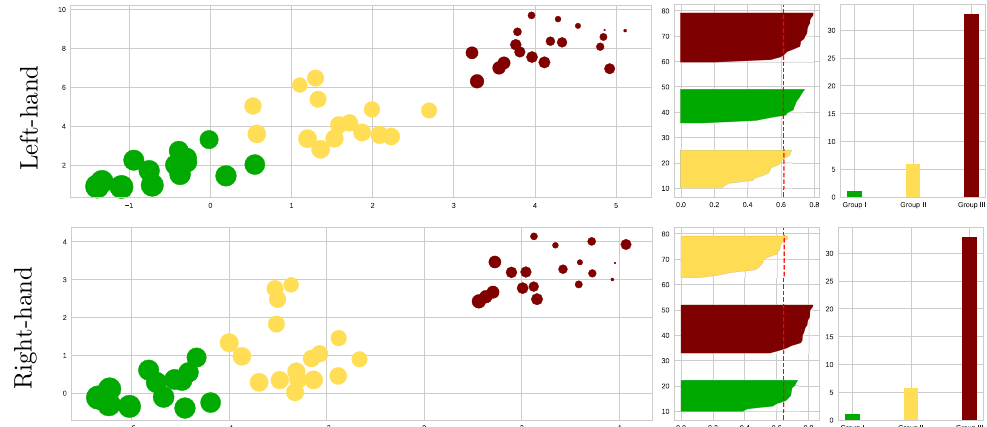
Figure 8. K − means clustering visualization of the EEG-Net classifier performance metrics and the Kolmogorov test values extracted from connectivity information. Left-side scatter plots of individuals (data points) estimated for the three considered groups of motor skills. Note that the point size represents the subject’s accuracy. The central plot shows the clustering metrics of the Silhouette coefficient, while the right-side plot displays the classifier performance, averaged across all subjects of each partition.